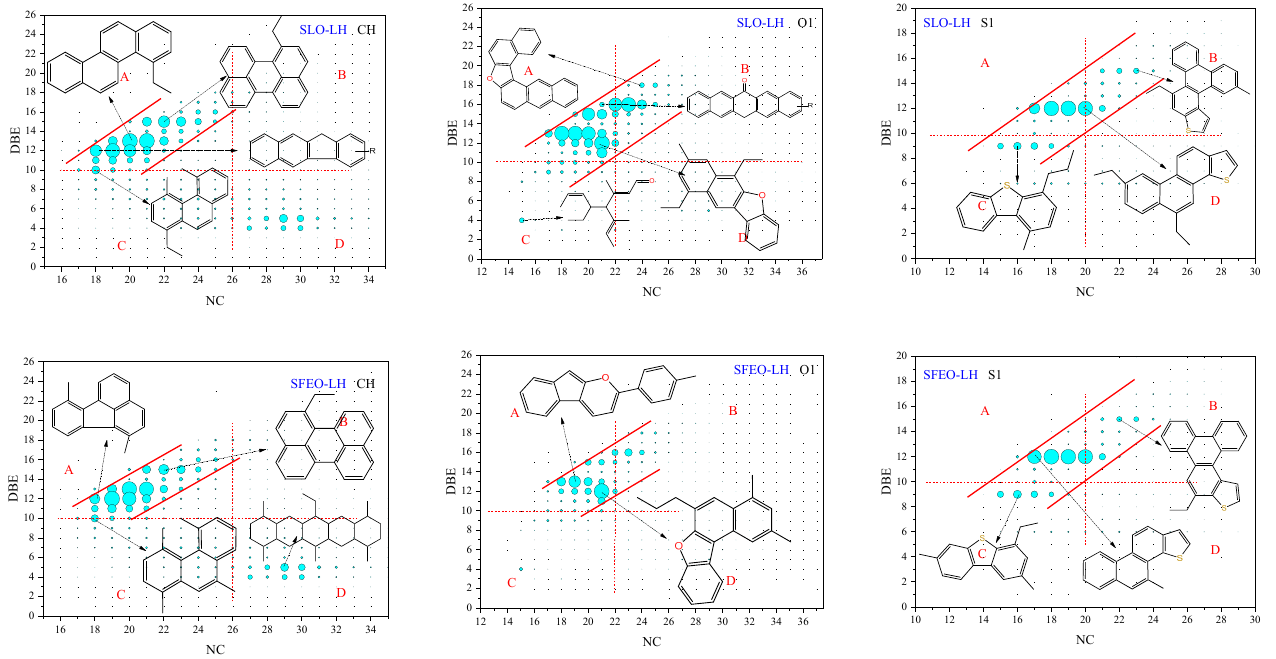
Figure 7. NC-DBE distribution of compounds in SLO–LH and SFEO–LH (APPI). (NC, number of carbon; DBE, double bond equivalents, The NC regions of CH, O1 and S1 compounds are demarcated at 26, 22, and 20, respectively. The DBE regions of CH, O1, and S1 compounds are demarcated at 10. For example, CH compounds in the A region (NC < 26 and DBE > 10)).